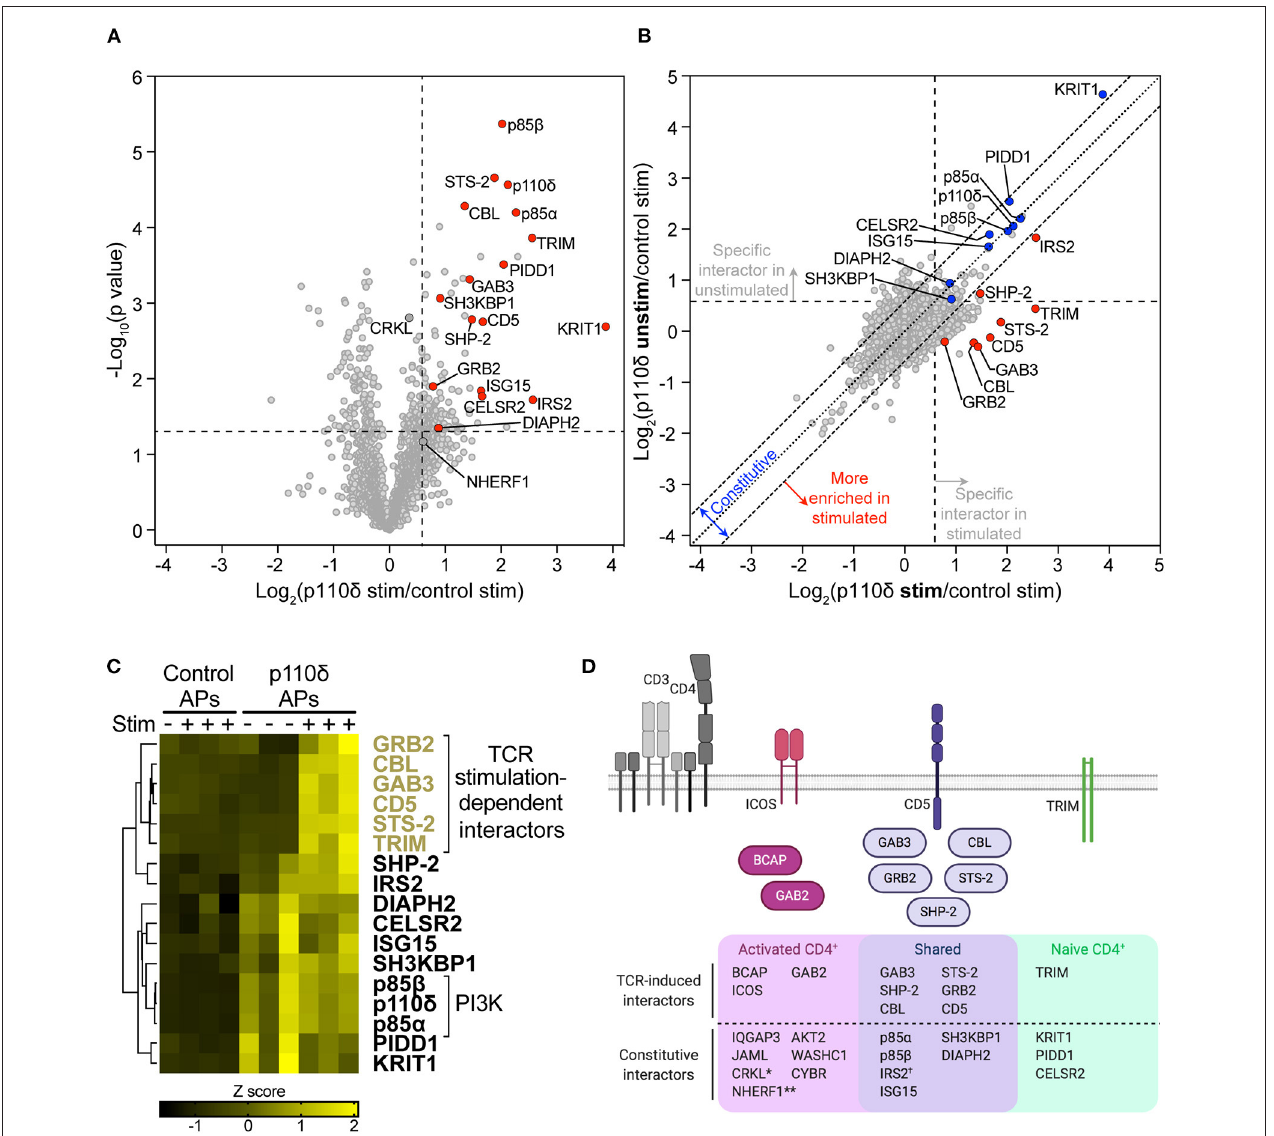
FIGURE 5 | The p110 δ interactome in naïve CD4 + T cells. (A) Volcano plot of proteins identified by mass spectrometry in APs from naïve CD4 + T cells. The plot shows the log 2 -difference in abundance of each protein in p110 δ APs compared to control APs from TCR-stimulated cells from three independent repeat experiments [Log 2 (p110 δ stim/control stim)] vs. the –Log 10 - p value, determined by a two-tailed Student’s t -test. Cells had been stimulated for 1min by CD3-CD4-crosslinking. The thresholds used to determine specific p110 δ -interactors (upper-right quadrant) are drawn at 1.5-fold enrichment and p = 0.05. Proteins of interest are represented by red points. Proteins identified as specific p110 δ -interactors in CD4 + T blasts that fall outside of the thresholds in naïve cells (CRKL, NHERF1) are filled dark grey. The full list of all proteins identified and t -test results can be found in Supplementary Datasheet 3 . (B) Scatter plot comparing the abundance of identified proteins in p110 δ purifications from TCR-stimulated and unstimulated naïve CD4 + T cells, relative to their abundance in control APs, from three independent repeat experiments. The diagonal dotted line indicates no difference between stimulated and unstimulated cells, while the diagonal dashed lines represent thresholds of 1.5-fold enrichment in either condition. The thresholds used to determine specific p110 δ -interactors are drawn as vertical and horizontal dashed lines for stimulated and unstimulated cells, respectively, indicating 1.5-fold enrichment in p110 δ APs compared to control APs. Specific interactors of interest are coloured blue (constitutive) and red (stimulation-induced). (C) Heatmap visualizing the Z score-normalised log 2 -protein abundance of specific p110 δ -interactors in control and p110 δ APs from unstimulated (–) and TCR-stimulated ( + ) naïve CD4 + T cells from three independent experiments. The result of hierarchical clustering of the data is represented by a dendrogram. (D) Diagram illustrating the proteins identified as part of the p110 δ interactome in naïve CD4 + T cells and activated CD4 + T cell blasts. The Venn diagram shows p110 δ -interactors common to the two cell differentiation stages (purple) and those identified in only in naïve (green) or activated (pink) CD4 + T cells. TCR stimulation-dependent interactors are also drawn as cartoons above the Venn diagram following the same colour scheme. NB.: *CRKL was weakly-enriched with p110 δ (1.28-fold; p = 0.0016) in stimulated naïve T cells; **NHERF1 was inconsistently enriched with p110 δ in stimulated naïve cells (1.52-fold; p = 0.0675); † The association of IRS2 with p110 δ in naïve cells was increased in TCR-stimulated compared to unstimulated cells, but was constitutive in T cell blasts.